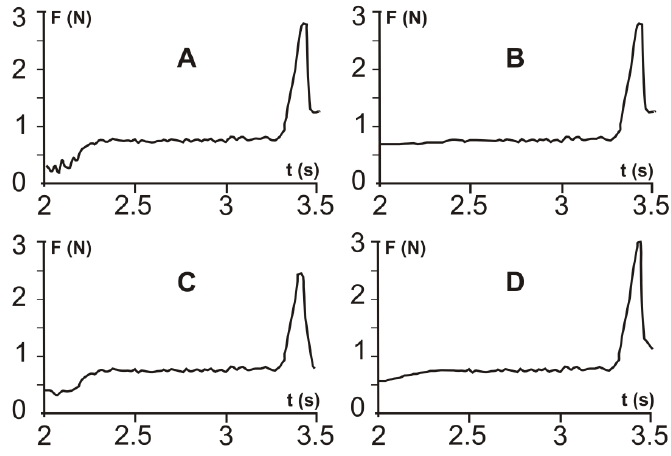
Figure 9. Representative fracture curves of the spherical agglomerates produced by the SA